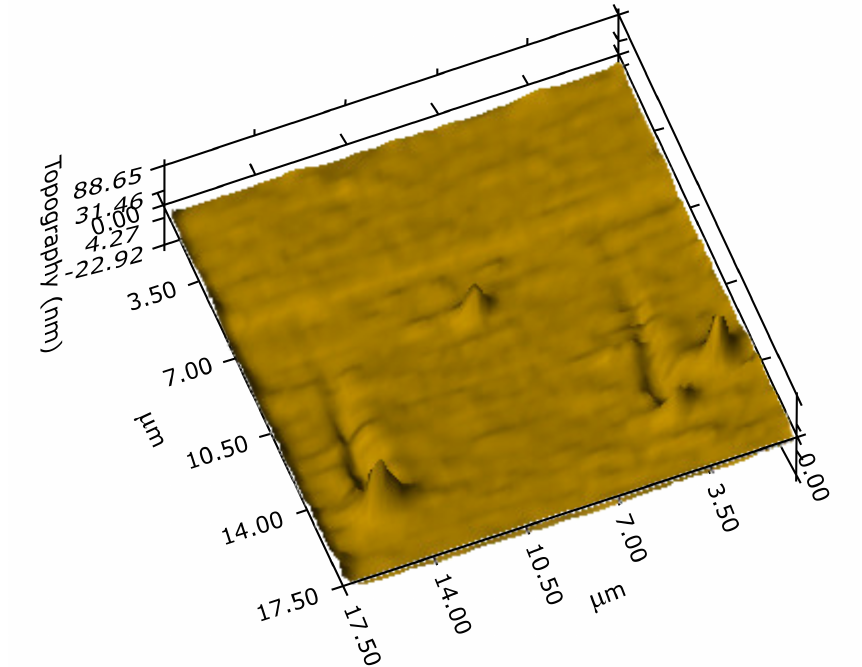
Figure 5. 3D image of two scratch lines made with ramping normal load linearly increasing up to 0.3 mN.